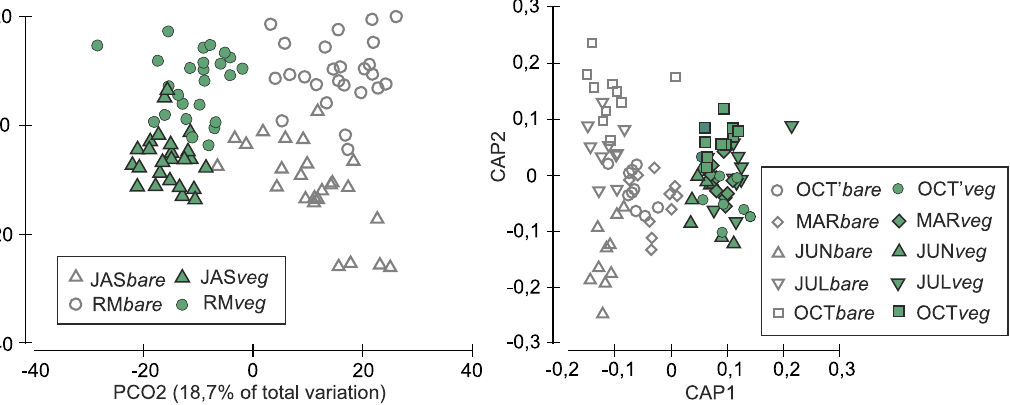
Figure 6. PCO of Bray-Curtis similarities of macrobenthic species abundances in samples (left) and CAP - ordination best discriminating groups of samples defined by bottom types and months (right). Data were double root transformed. Symbols represent sites/bottom types (left) and months/bottom types (right).